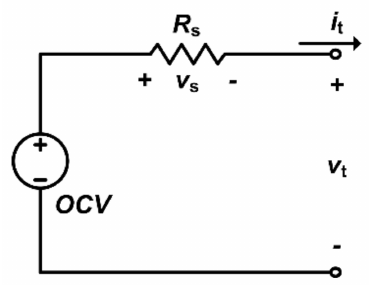
Figure 2. Equivalent circuit model for a lithium-ion battery.